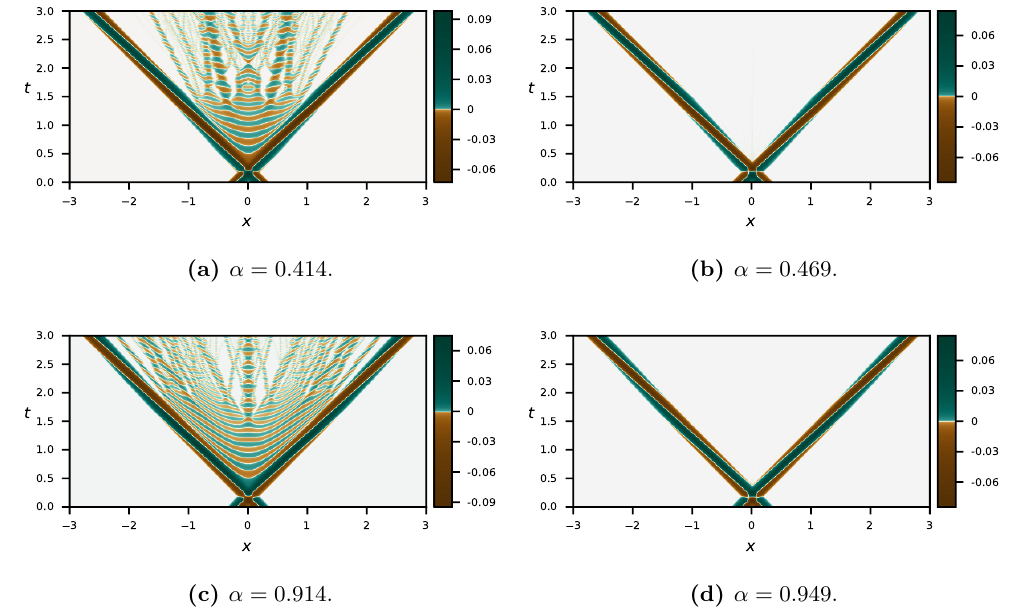
Figure 27 . The scattering process for initial symmetric con(cid:12)guration containing oscillons with speed V = 0 : 93, velocity of the border v = 0 : 2 and di(cid:11)erent phases (cid:11) .